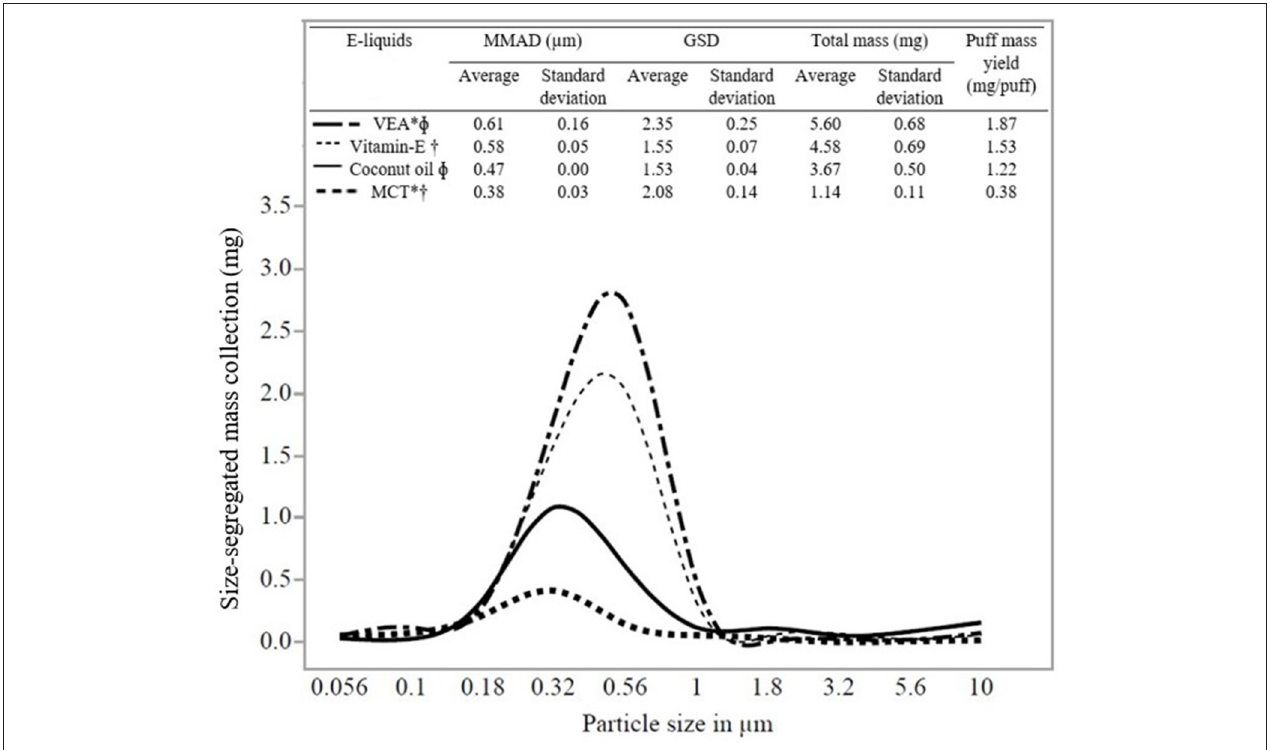
FIGURE 2 | Size distribution (MMAD and GSD), puff mass yield, and statistical comparisons of e-liquids. Note that the total (non-size-segregated) mass presented at the top is different from the size-segregated mass collection presented in the y-axis. E-liquids connected by the same symbols are significantly different. * VEA and MCT are significantly different. 8 VEA and coconut oil are significantly different. † Vitamin E oil and MCT are significantly different.